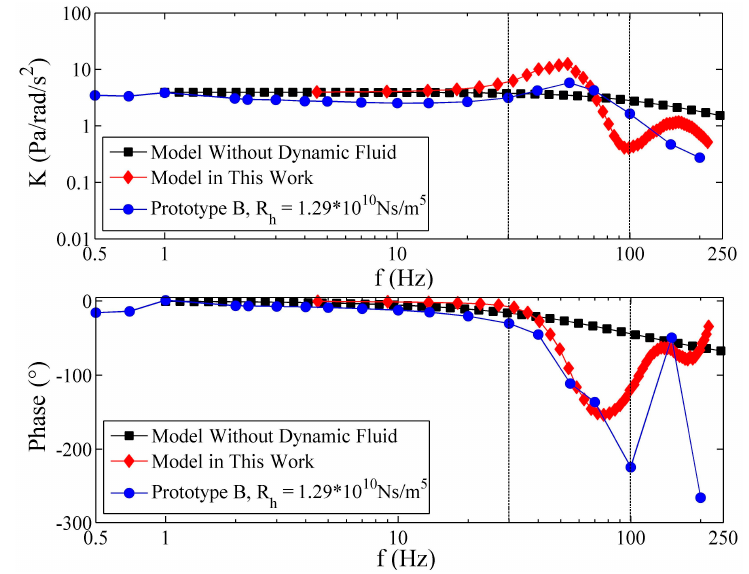
Figure 12. Comparisons among the experimental frequency response and the theoretical results of Prototype B. Table 4. Determination of the loss factor.